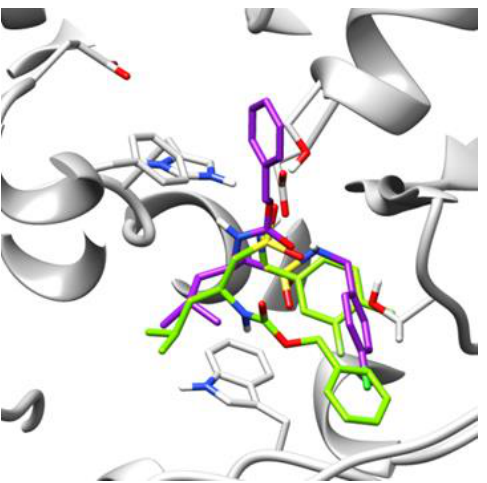
Figure 1. View of spatial configuration adopted by 5j (violet) and 5l (green) within the active site of BChE. Notice the extended conformation of 5j (IC 50 = 6.57 µM) and the V-shaped conformation of 5l (IC 50 = 55.64 µM).